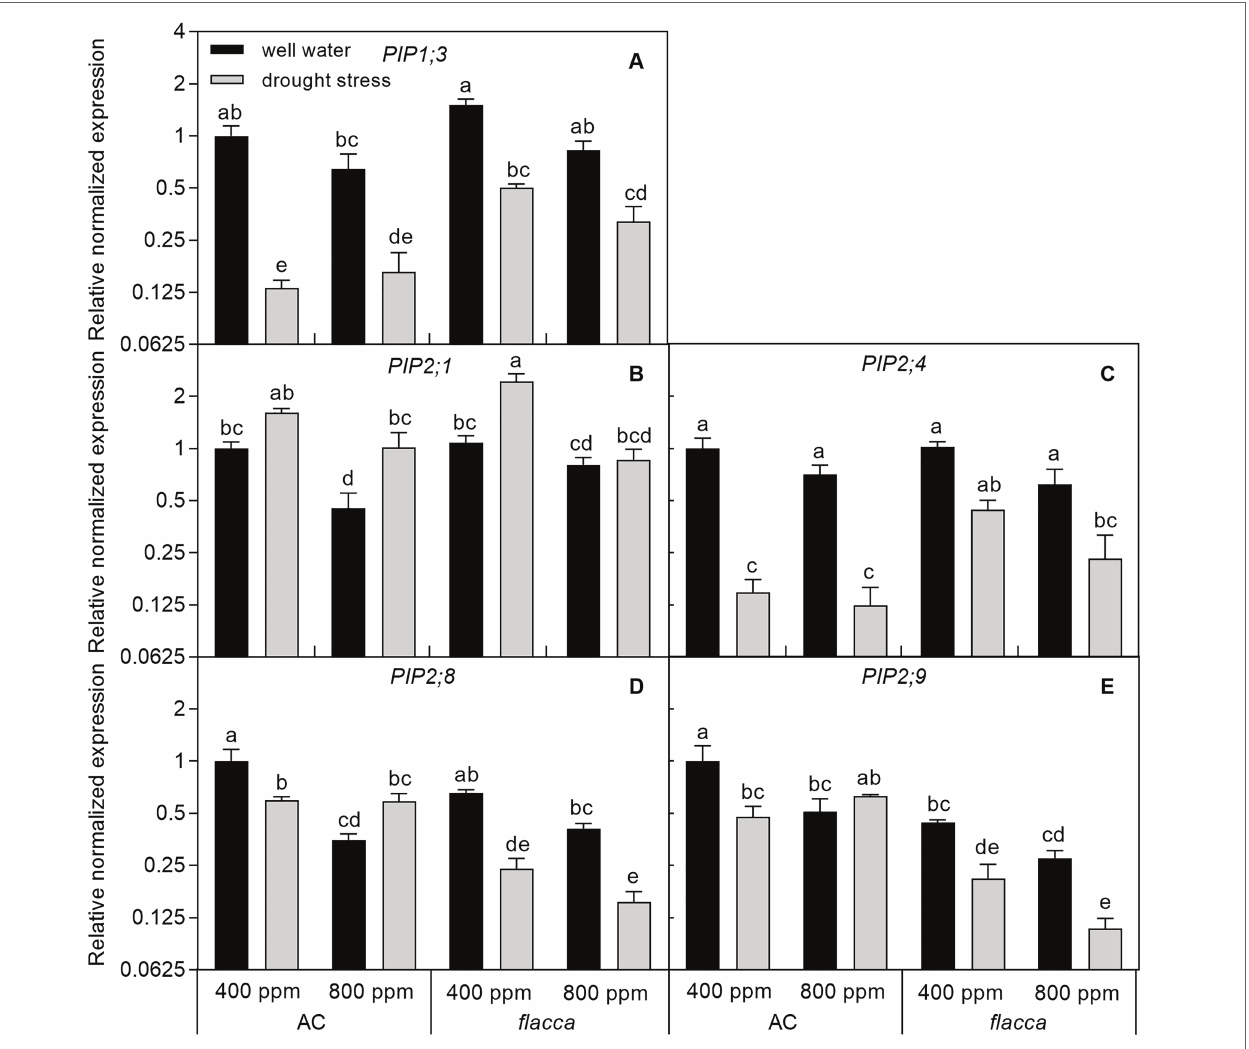
FIGURE 6 | Relative expression levels of genes encoding the plasma membrane intrinsic proteins (PIPs) (A-E) in roots of AC and flacca grown under ambient (400 ppm) and elevated (800 ppm) atmospheric CO 2 concentrations after progressive soil drying. Gray columns indicate plants grown under well-watered conditions, and white columns indicate plants grown under drought stress. Different letters on the top of the columns for each PIP indicate significant difference between the treatments by Tukey’s test at p < 0.05. Error bars indicate standard error of the means (SE; N =